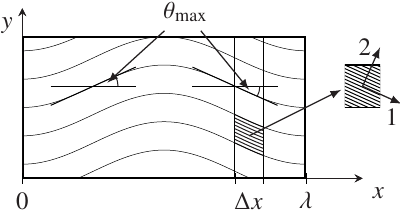
Figure 17. Representative waviness region defined by the amplitude A and the wavelength λ